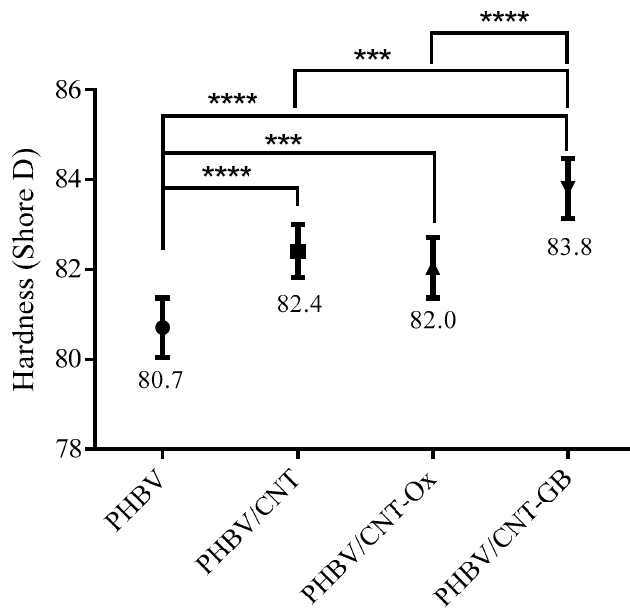
Figure 10. Shore D hardness for PHBV, PHBV/CNT, PHBV/CNT-Ox and PHBV/CNT-GB. Significance levels: *p ≤ 0.05; **p < 0.01; ***p < 0.001; ****p < 0.0001.